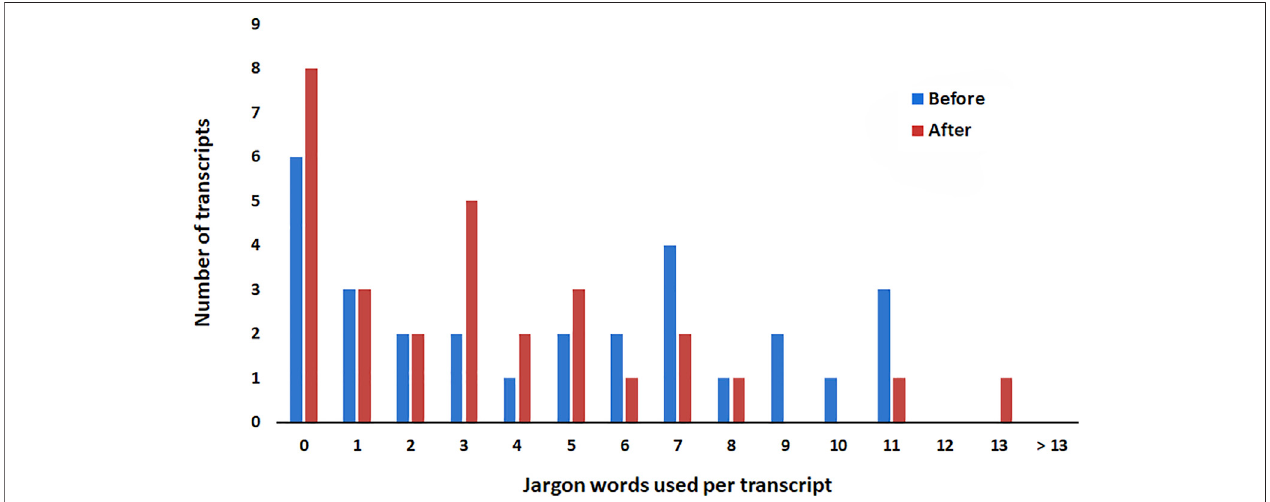
FIGURE 3 | Frequency of jargon use, per transcript, before (blue) and after (red) science communication training. After training, the number of transcripts in which trainees used jargon three or fewer times rose as the number of transcripts with high jargon frequency fell.